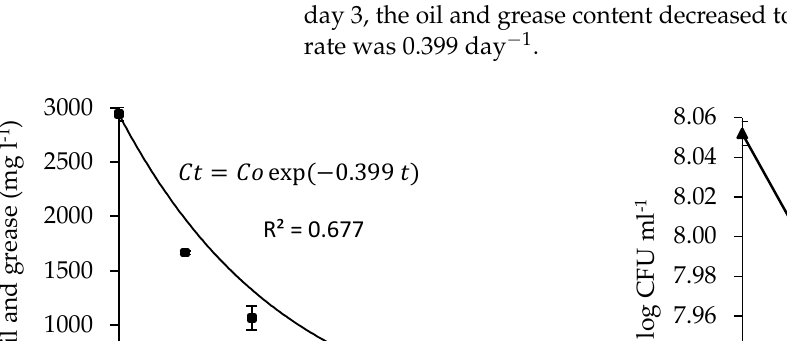
Figure 7. ( a ) The biodegradation rate of oil ( ), ( b ) bacteria population ( ), and pH ( ) during experiment.